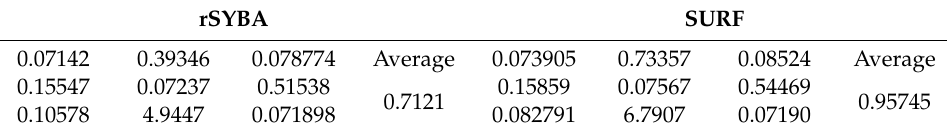
Table 5. Average relative error results for 3 × 3 homography matrix across all images.